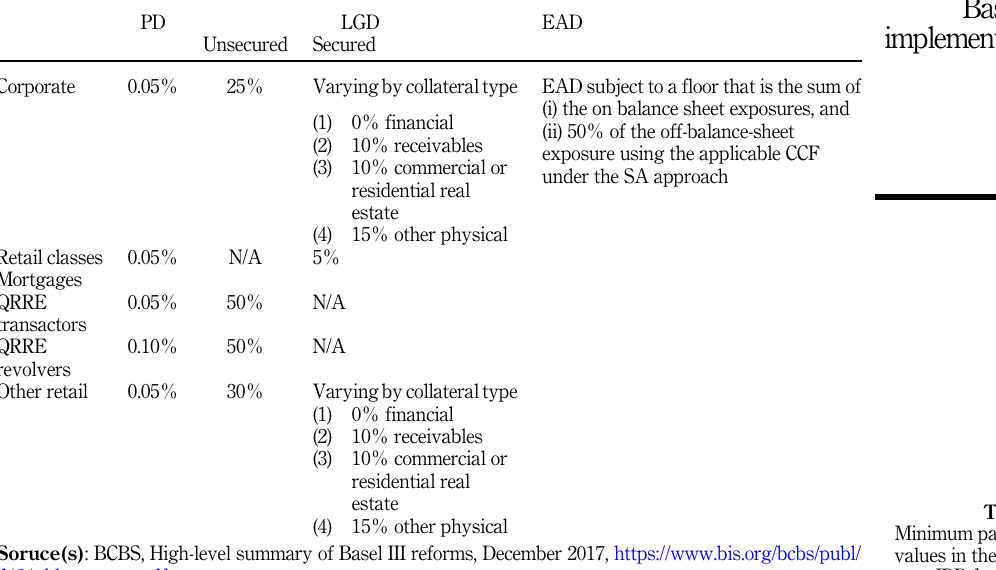
Table 8. Minimum